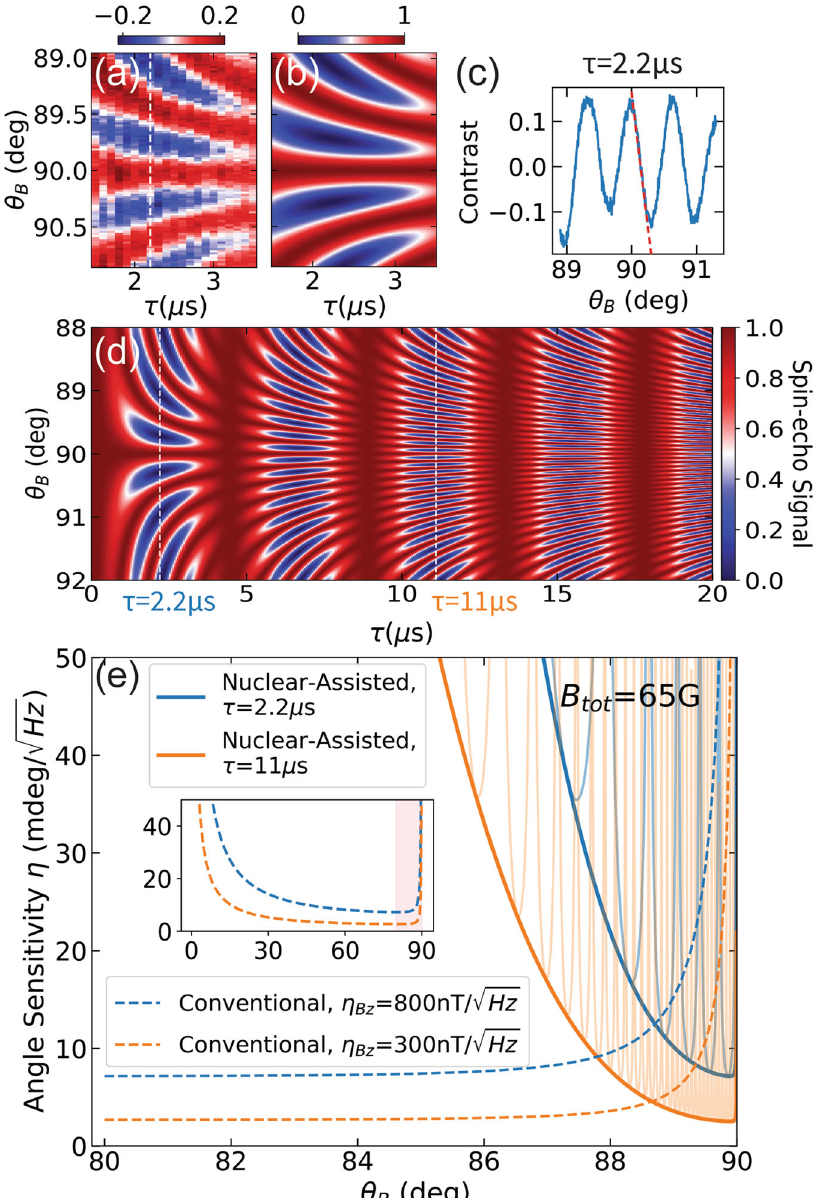
echo amplitude in ( b ). c The experimental spin-echo signal at fi xed τ = 2.2 μ s (white dashed line in ( a )). The red dashed line denotes the largest slope as θ B varies. d Spin-echo calculation in broader θ B and τ ranges, where the two white dashed lines mark the fi xed τ times at which sensitivities are plotted in ( e ). e Comparison of angle sensitivities using the nuclear-assisted method (solid curves) in this work